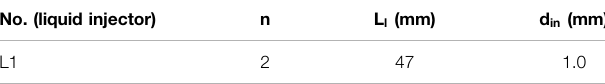
TABLE 1 | The geometric parameters of the present gaseous injectors. TABLE 2 | The geometric parameters of the present liquid